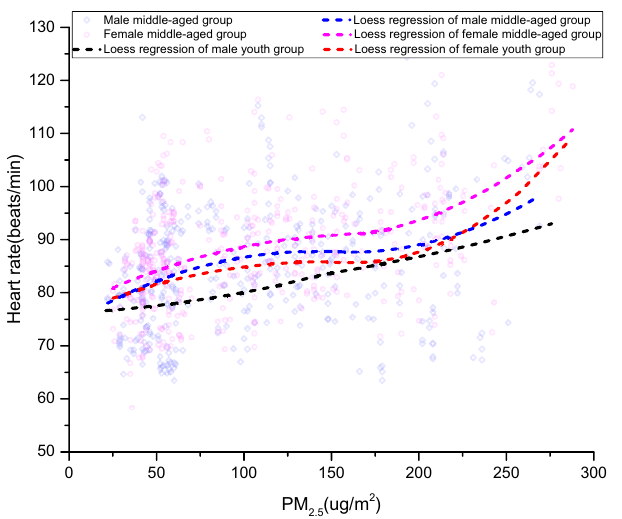
Figure 3. Variation tendency of heart rate.